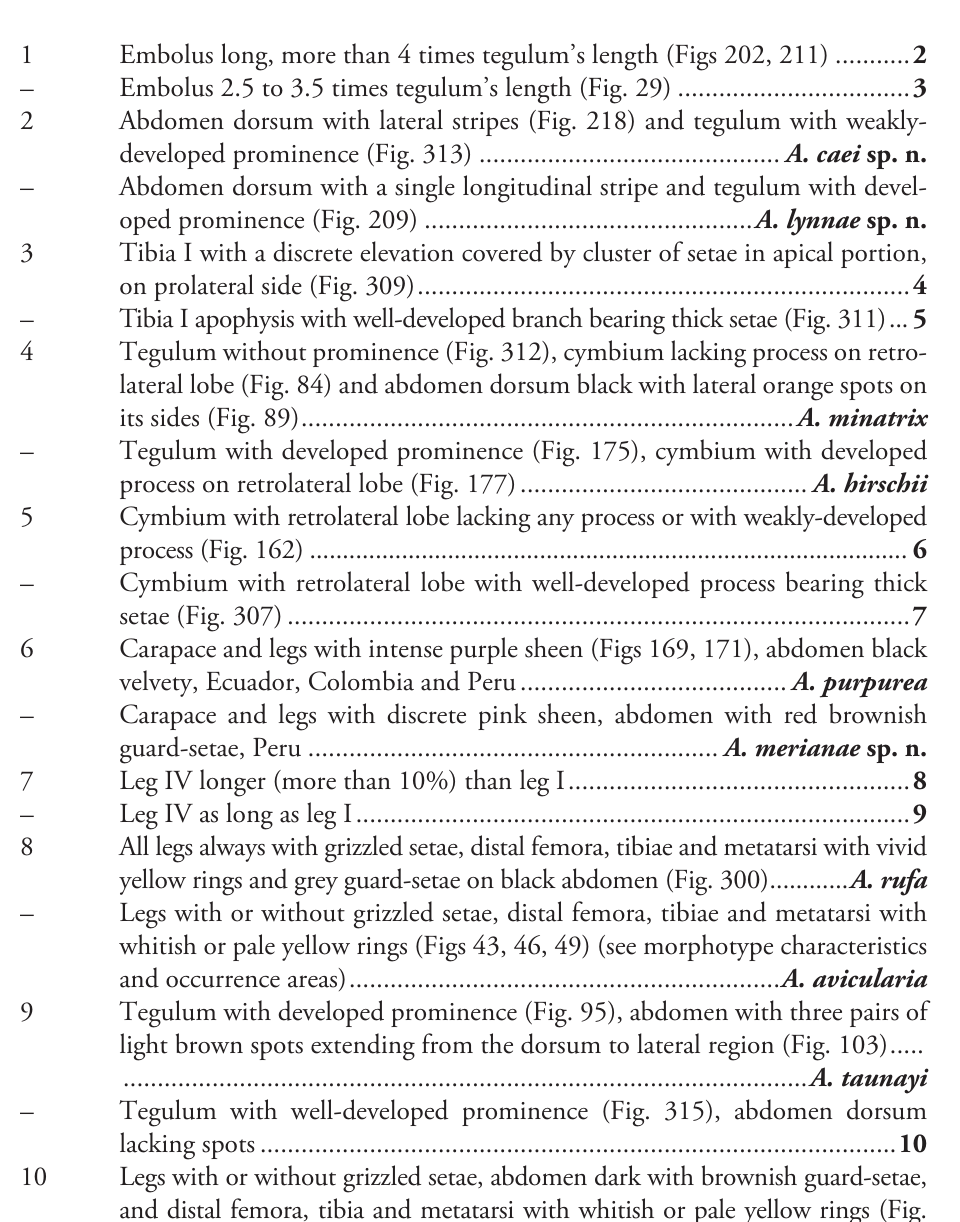
1 Embolus long, more than 4 times tegulum’s length (Figs 202, 211) ........... 2 – Embolus 2.5 to 3.5 times tegulum’s length (Fig. 29) .................................. 3 2 Abdomen dorsum with lateral stripes (Fig. 218) and tegulum with weakly- developed prominence (Fig. 313) ............................................ A. caei sp. n. – Abdomen dorsum with a single longitudinal stripe and tegulum with devel- oped prominence (Fig. 209) ................................................ A. lynnae sp. n. 3 Tibia I with a discrete elevation covered by cluster of setae in apical portion, on prolateral side (Fig. 309) ........................................................................ 4 – Tibia I apophysis with well-developed branch bearing thick setae (Fig. 311) ... 5 4 Tegulum without prominence (Fig. 312), cymbium lacking process on retro- lateral lobe (Fig. 84) and abdomen dorsum black with lateral orange spots on its sides (Fig. 89) ........................................................................ A. minatrix – Tegulum with developed prominence (Fig. 175), cymbium with developed process on retrolateral lobe (Fig. 177) .......................................... A. hirschii 5 Cymbium with retrolateral lobe lacking any process or with weakly-developed process (Fig. 162) ........................................................................................... 6 – Cymbium with retrolateral lobe with well-developed process bearing thick setae (Fig. 307) ........................................................................................... 7 6 Carapace and legs with intense purple sheen (Figs 169, 171), abdomen black velvety, Ecuador, Colombia and Peru ....................................... A. purpurea – Carapace and legs with discrete pink sheen, abdomen with red brownish guard-setae, Peru ............................................................ A. merianae sp. n. 7 Leg IV longer (more than 10%) than leg I .................................................. 8 – Leg IV as long as leg I ................................................................................. 9 8 All legs always with grizzled setae, distal femora, tibiae and metatarsi with vivid yellow rings and grey guard-setae on black abdomen (Fig. 300) ............ A. rufa – Legs with or without grizzled setae, distal femora, tibiae and metatarsi with whitish or pale yellow rings (Figs 43, 46, 49) (see morphotype characteristics and occurrence areas) ............................................................... A. avicularia 9 Tegulum with developed prominence (Fig. 95), abdomen with three pairs of light brown spots extending from the dorsum to lateral region (Fig. 103) ..... .................................................................................................... A. taunayi – Tegulum with well-developed prominence (Fig. 315), abdomen dorsum lacking spots ............................................................................................. 10 10 Legs with or without grizzled setae, abdomen dark with brownish guard-setae, and distal femora, tibia and metatarsi with whitish or pale yellow rings (Fig. 121) (see morphotype characteristics and occurrence areas) .......... A. juruensis – Legs with grizzled setae, abdomen black with brownish guard-setae and distal femora, tibia and metatarsi with whitish or pale yellow rings (Figs 71, 75) ... ..................................................................................... A. variegata stat.